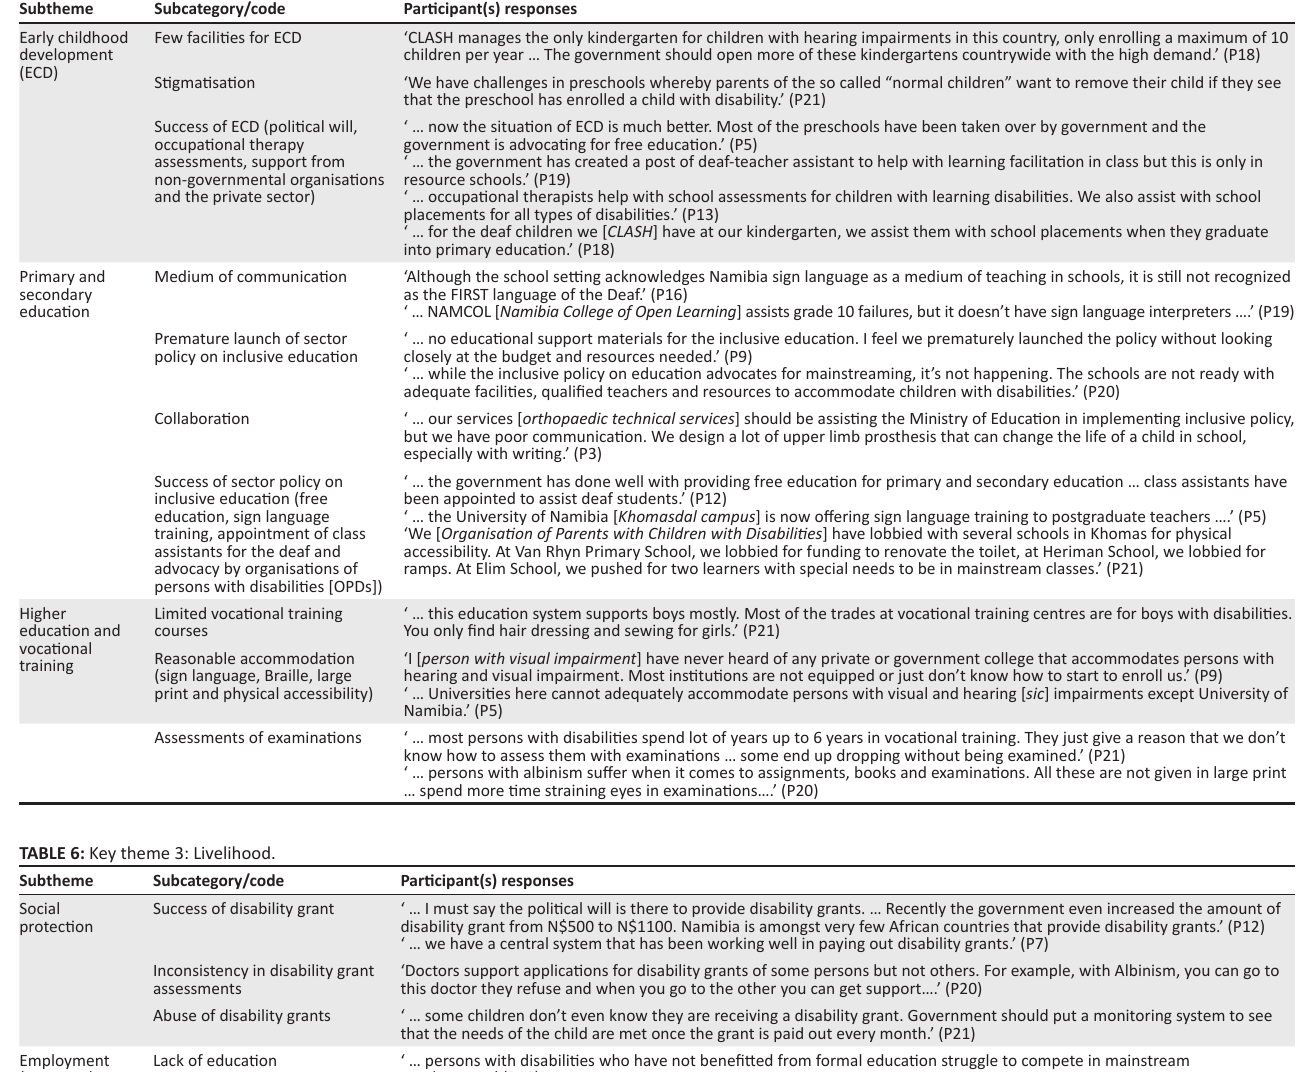
TABLE 5: Key theme 2: Education.